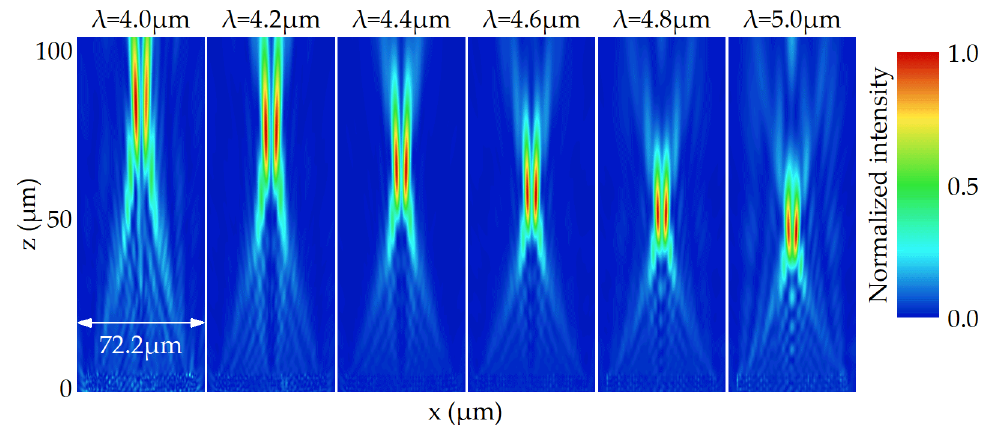
Figure 8. The simulated electric field intensity on the x-z plane for the FVBG with hyper-negative dispersion between 4.0 and 5.0 μ m.